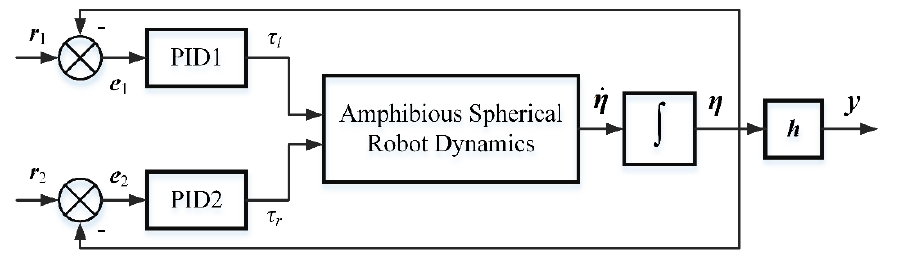
Figure 4. Control block diagram of the robot.